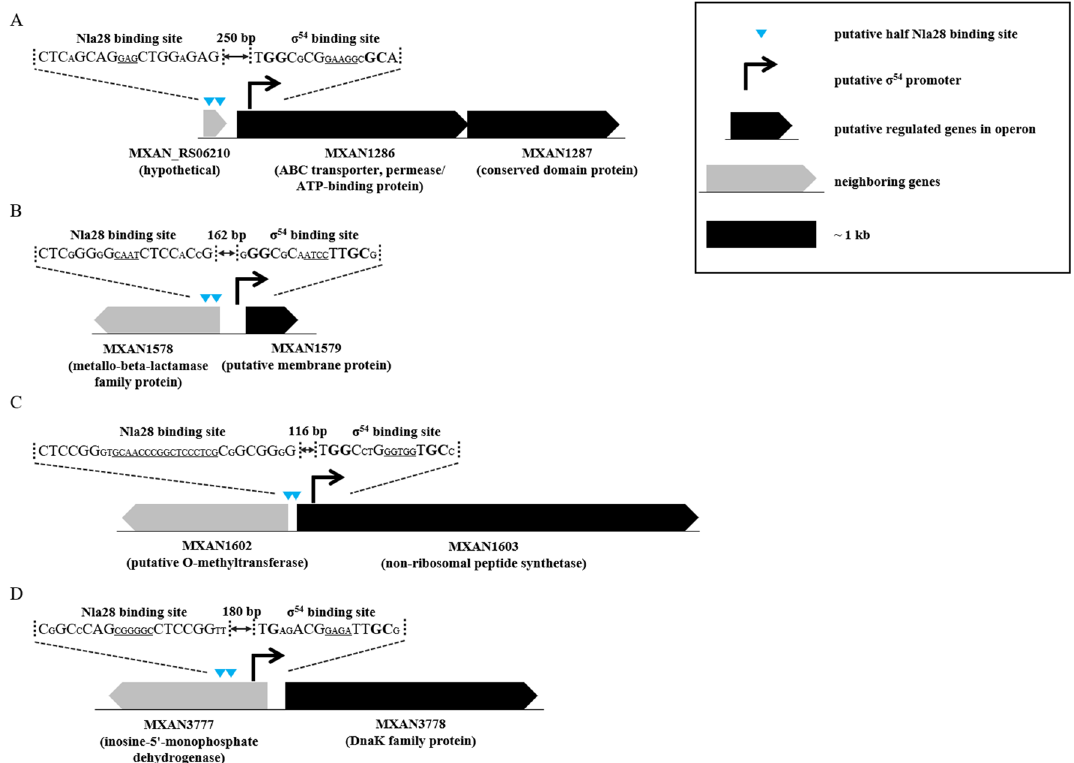
polymerase binding site are relatively large. The conserved GC dinucleotide in − 12-bp region and the conserved GG dinucleotide in − 24-bp region of the putative σ 54 RNA polymerase binding sites are in bold. The underlined nucleotides represent the spacers between the two half Nla28 binding sites or the spacers between − 12 and − 24-bp promoter